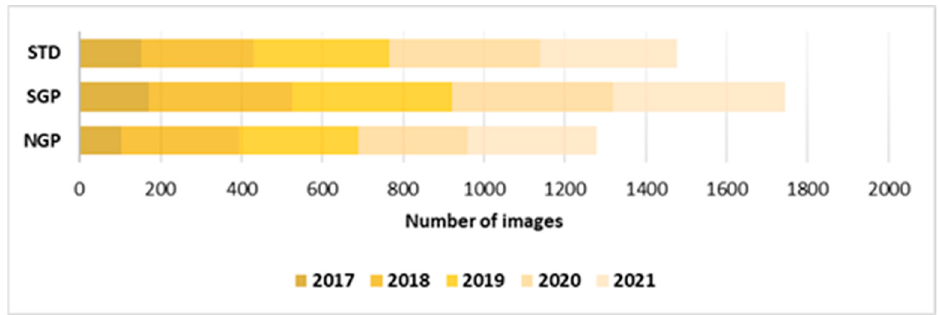
Figure 3. Number of high-quality Sentinel-2 images used in the study.